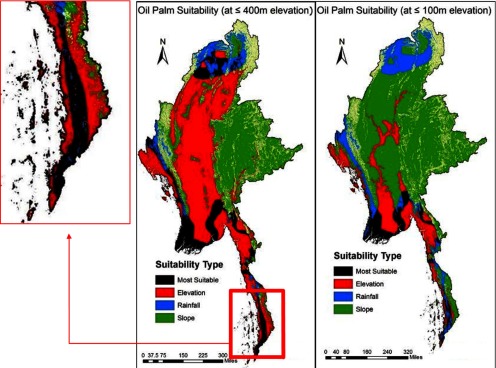
Land Suitability AnalysisThe most suitable area represents land with rainfall between 2,400 and 3,200 mm/year, on a slope of <16%, and at an elevation of either <400 m (left) or <100 m (right), the latter based on studies conducted in Malaysia28 and Myanmar,10 respectively. There is 38% more “most suitable” land in the 400 m versus 100 m elevation models. The expanded area is the Tanintharyi region where both this model and literature reviews confirm palm oil development will take place.